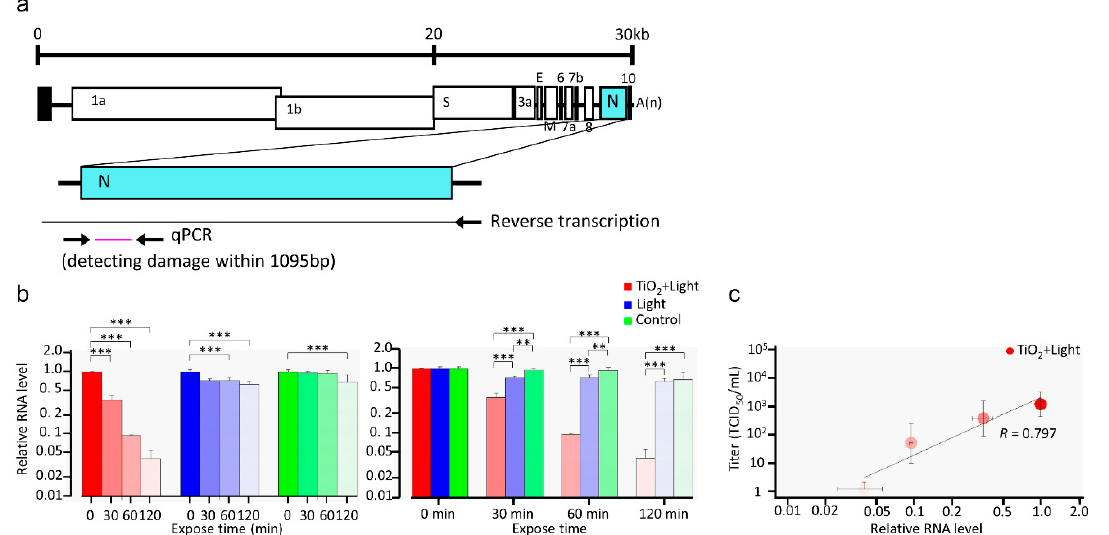
Figure 4. Damage to SARS-CoV-2 RNA by LED-TiO 2 photocatalytic reaction. ( a ) Schematic diagram of RT-qPCR primer- binding sites. ( b ) SARS-CoV-2 (1 mL) titer of 1.0 × 10 5 TCID 50 /mL was placed on the TiO 2 -coated sheet and subjected to photocatalytic reaction for 0, 30, 60, and 120 min, and then viral RNA was extracted and measured by RT-qPCR. The relative RNA level compared to that in samples obtained at 0 min after LED light irradiation was calculated. All values in each group were compared with the 0 min sample by two-way ANOVA with Dunnett’s test (left panel). All values at each time point were analyzed by two-way ANOVA followed by Tukey’s test (right panel). ( c ) Linear regression analysis between SARS-CoV-2 infectivity (Figure 1) and RNA level. Each column and error bar represent the mean ± SD of results for two experiments. Asterisk indicates a statistically significant difference (** p < 0.01; *** p < 0.001). R indicates the Pearson correlation coefficient.